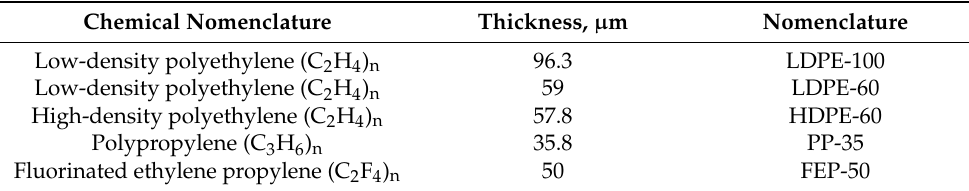
Table 1. Candidate materials for radiative cooling wind-shields.